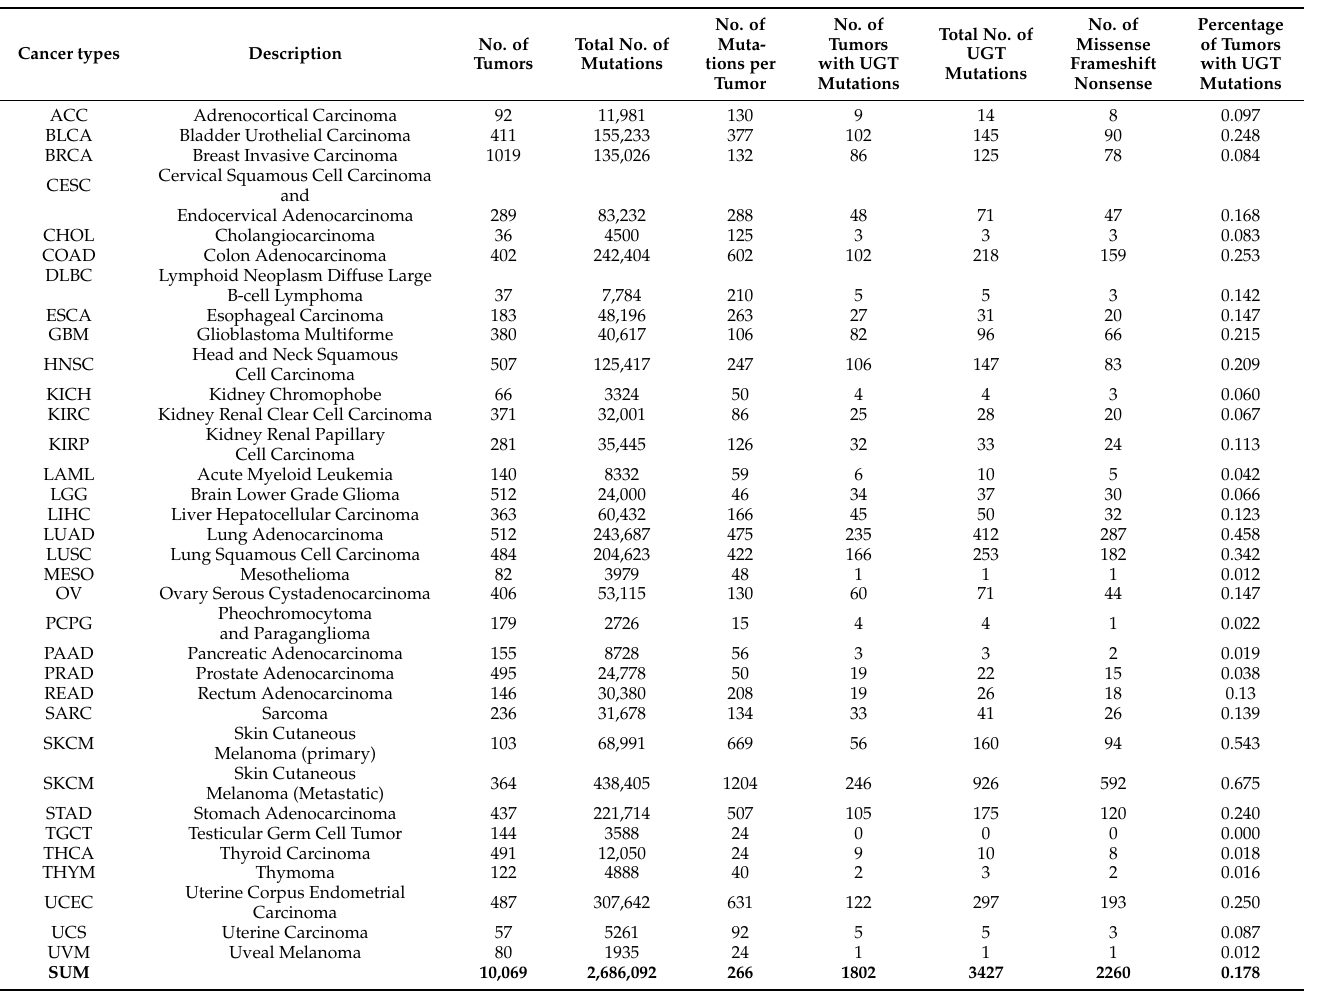
Table 1. Somatic mutations in UGT genes in 33 different TCGA cancer